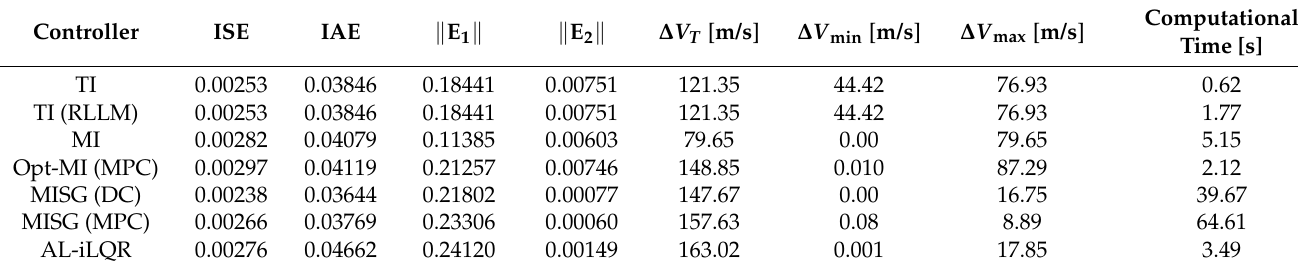
Table 2. Performance comparison for the impulsive guidance